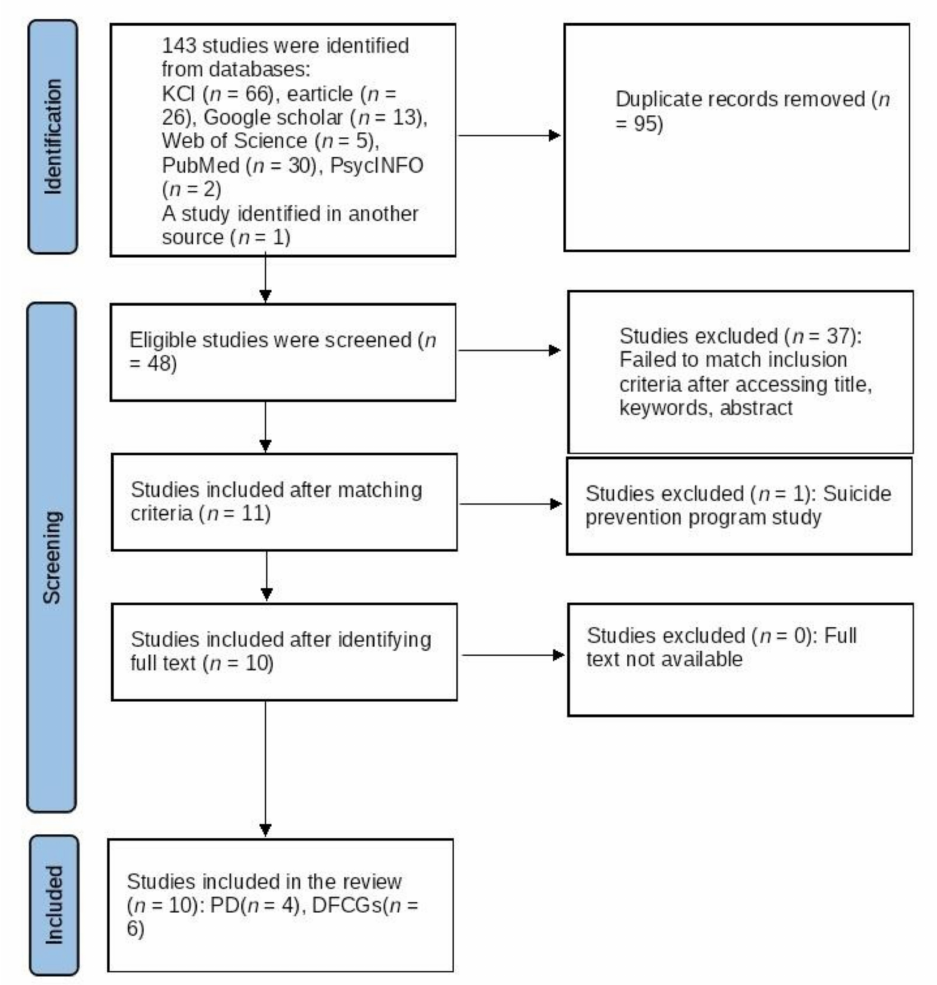
Figure 1. PRISMA flow diagram of studies on suicide risk among people with dementia and dementia family caregivers. PD: People with dementia. DFCGs: Dementia family